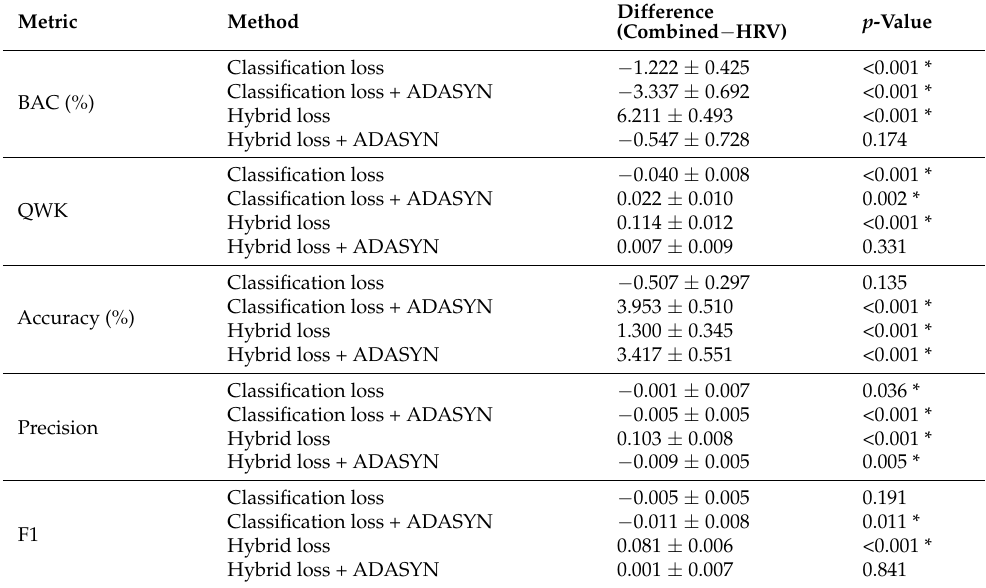
Table 9. Mean and 95% CI of difference in performance metrics between the combined and HRV models. The differences were calculated by subtracting the value of an HRV model from that of a combined model. A two-sample t -test was performed to compare the metrics from the two models (* p < 0.05).